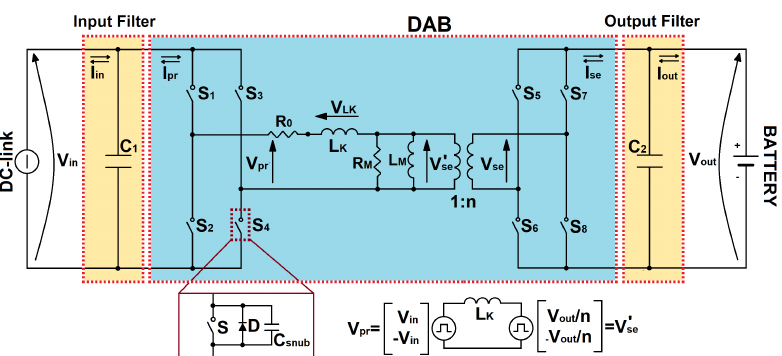
Figure 8. Topology of bidirectional dual-active-bridge converter.